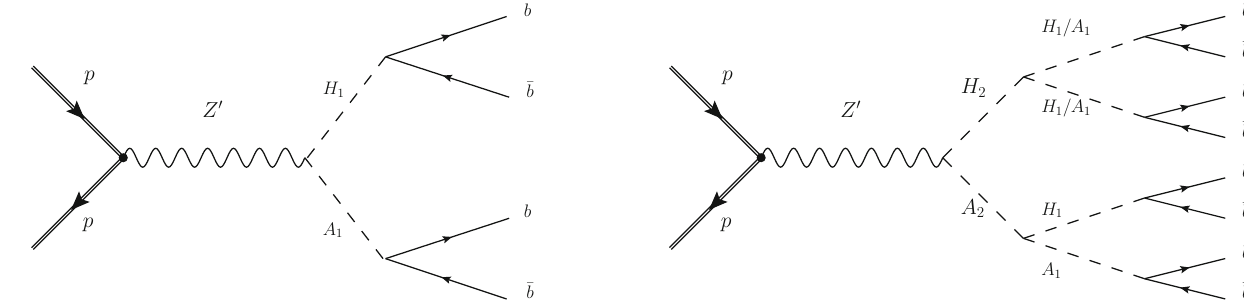
Fig. 3 Cascade decay of the Z (cid:2) boson into scalars producing exotic diboson and multiboson final states ¯ b via small mixings with the can decay into W W , Z Z and b neutral scalar Higgses H u and H d , but in relevant regions of the parameter space is expected to predominantly decay into H 1 H 1 and A 1 A 1 , as depicted on the right panel. The partial widths for the different modes